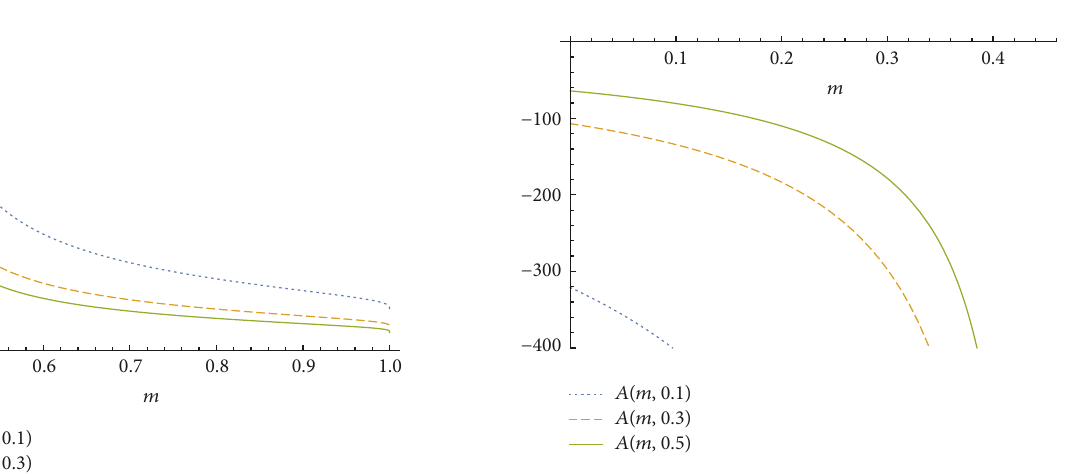
Figure 7: Amplitude 𝐴(𝑚, 𝛼) (43) of solution (4) as function of 𝑚 for 𝛼 = 0.1, 0.3, 0.5 .